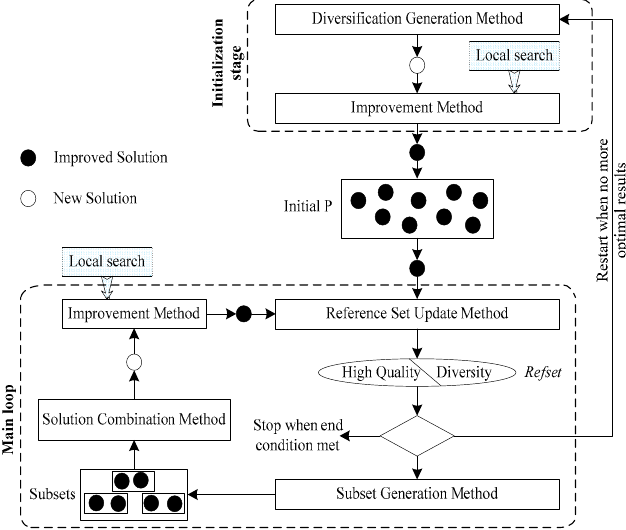
Figure 1. Schematic of a standard scatter search (SS) template .